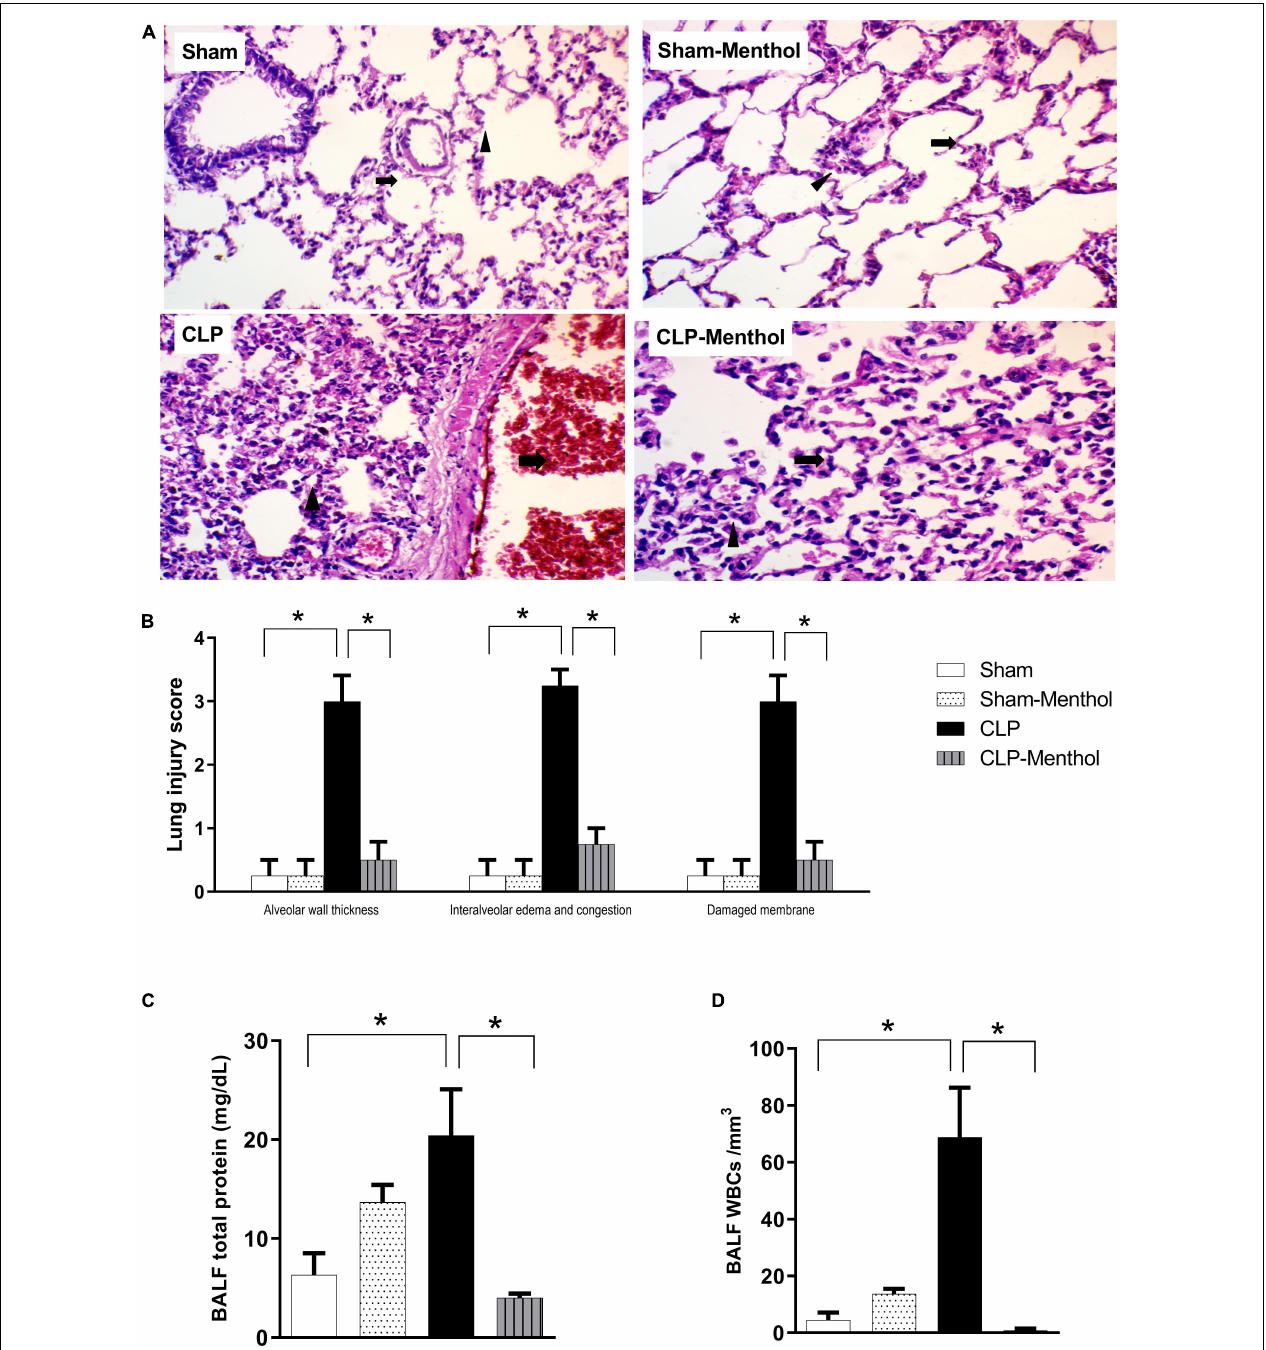
FIGURE 2 | Effect of menthol on sepsis-induced acute lung injury. Sepsis was induced by CLP under general anesthesia as described under the “Materials and Methods” section. Animals were killed after 24 h of CLP and the lung injury was assessed by histological examination of H&E-stained (200 × ) sections (A,B) and by determination of the protein and total WBCs in the bronchoalveolar lavage (BALF; C,D ) in all groups ( n = 6 per group). (A) Representative photomicrographs showing that menthol treatment attenuated the histopathological changes induced by sepsis in the lung tissue. The sham groups (Sham and Sham-Menthol) showed normal lung alveolar spaces (arrow) separated by non-congested vascular spaces (arrowhead). The lung tissue of the vehicle-treated CLP group (CLP) showed thickened alveolar spaces with alveolar wall damage (arrow) separated by dilated and congested vascular spaces (arrowhead). Lung tissues from the menthol-treated septic rats (CLP-Menthol) showed normal alveolar spaces with intact alveolar wall (arrow) separated by mild congested vascular spaces (arrowhead). Summary of the mean values of the combined lung injury scores (at least 10 fields per section from 6 animals) of different groups is shown (B) . The total protein content (C) and the total leucocyte count (D) in BALF of different groups ( n = 6) are also shown. Data represent the mean ± SEM of 6 independent observations. Data were analyzed by one-way ANOVA followed by the Tukey-Kramer post- test for multiple comparisons. *Significantly different at p < 0.05 compared to the CLP group.